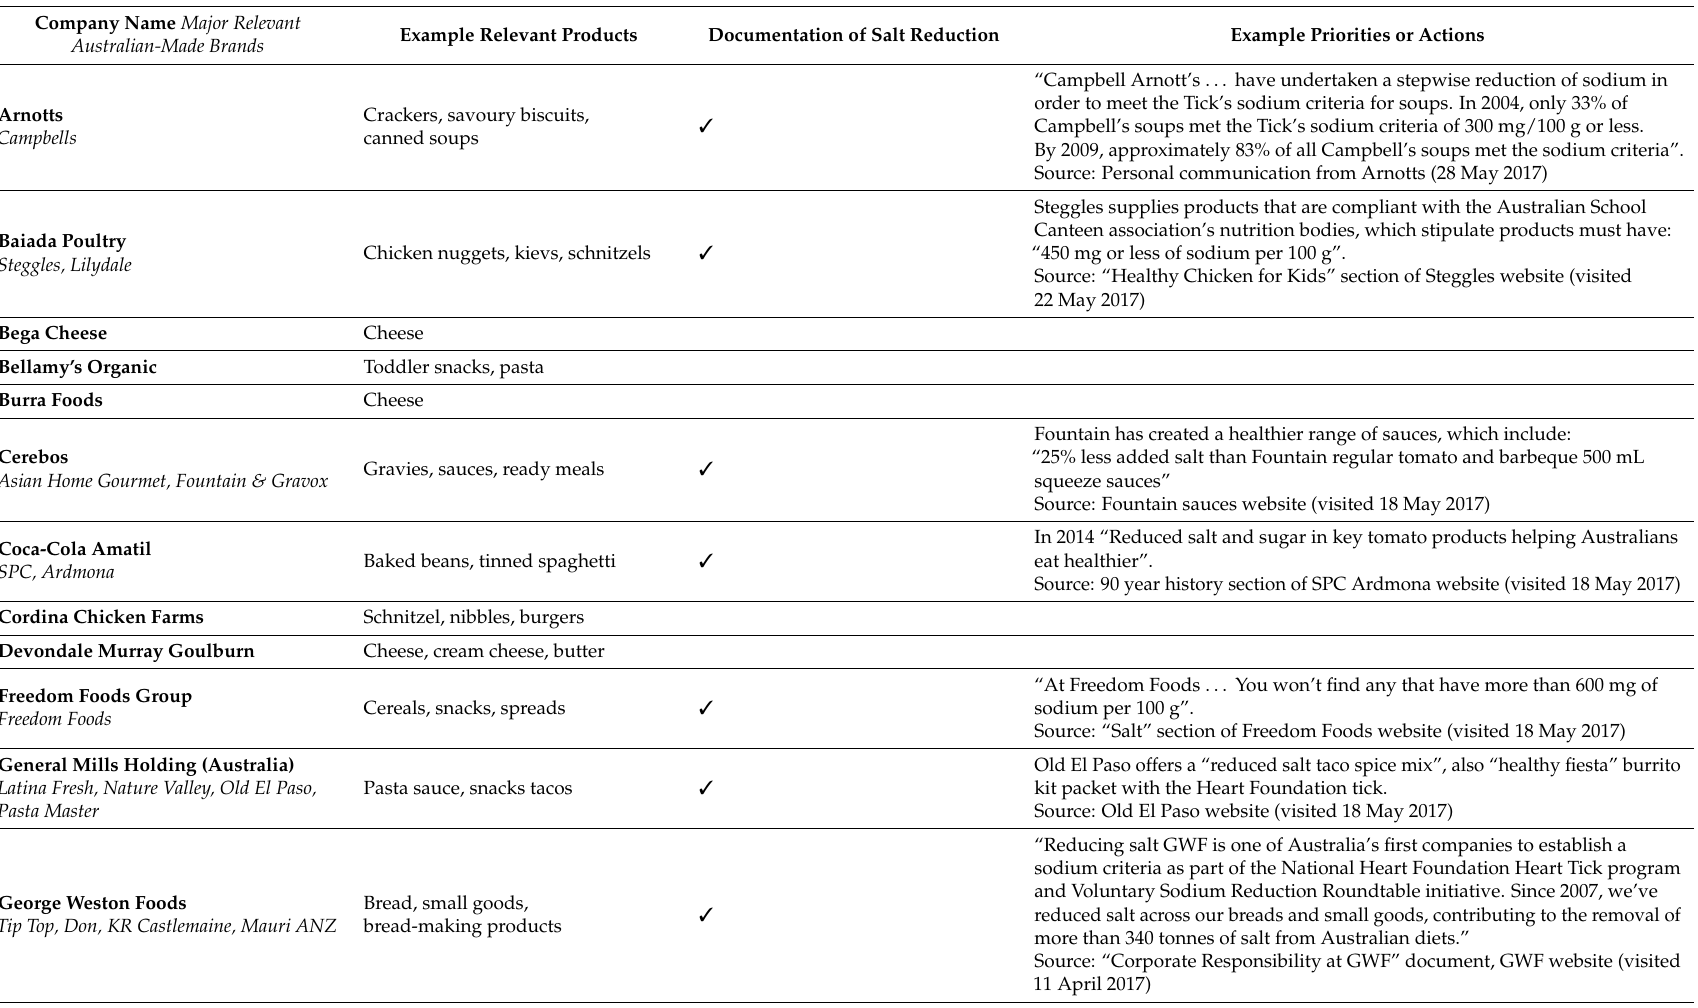
Table 3. Priorities and actions publically reported by Australian food